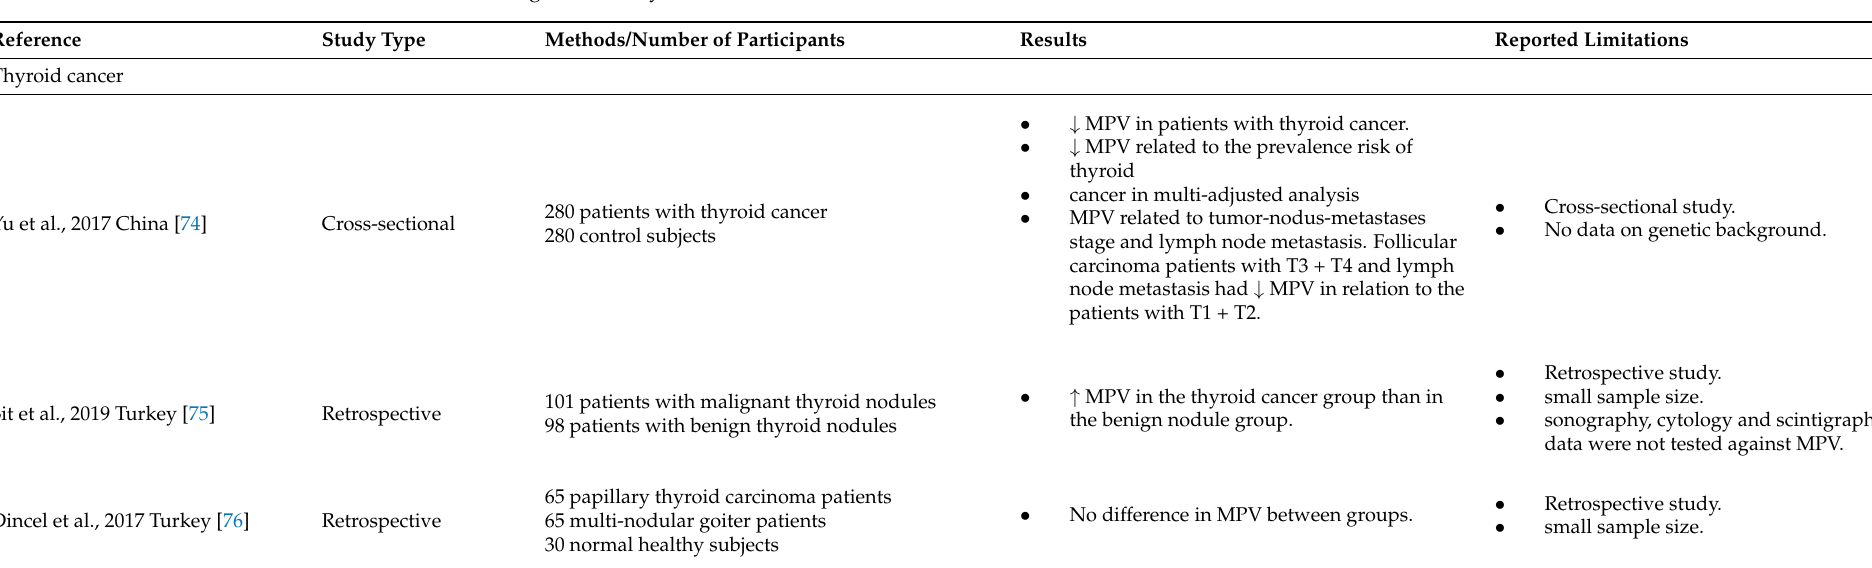
Table 5. Studies relating MPV to thyroid